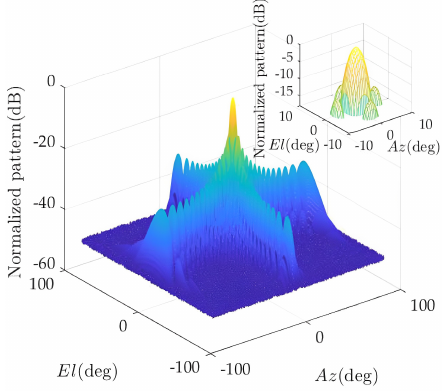
Figure 6. Pattern of antenna array before